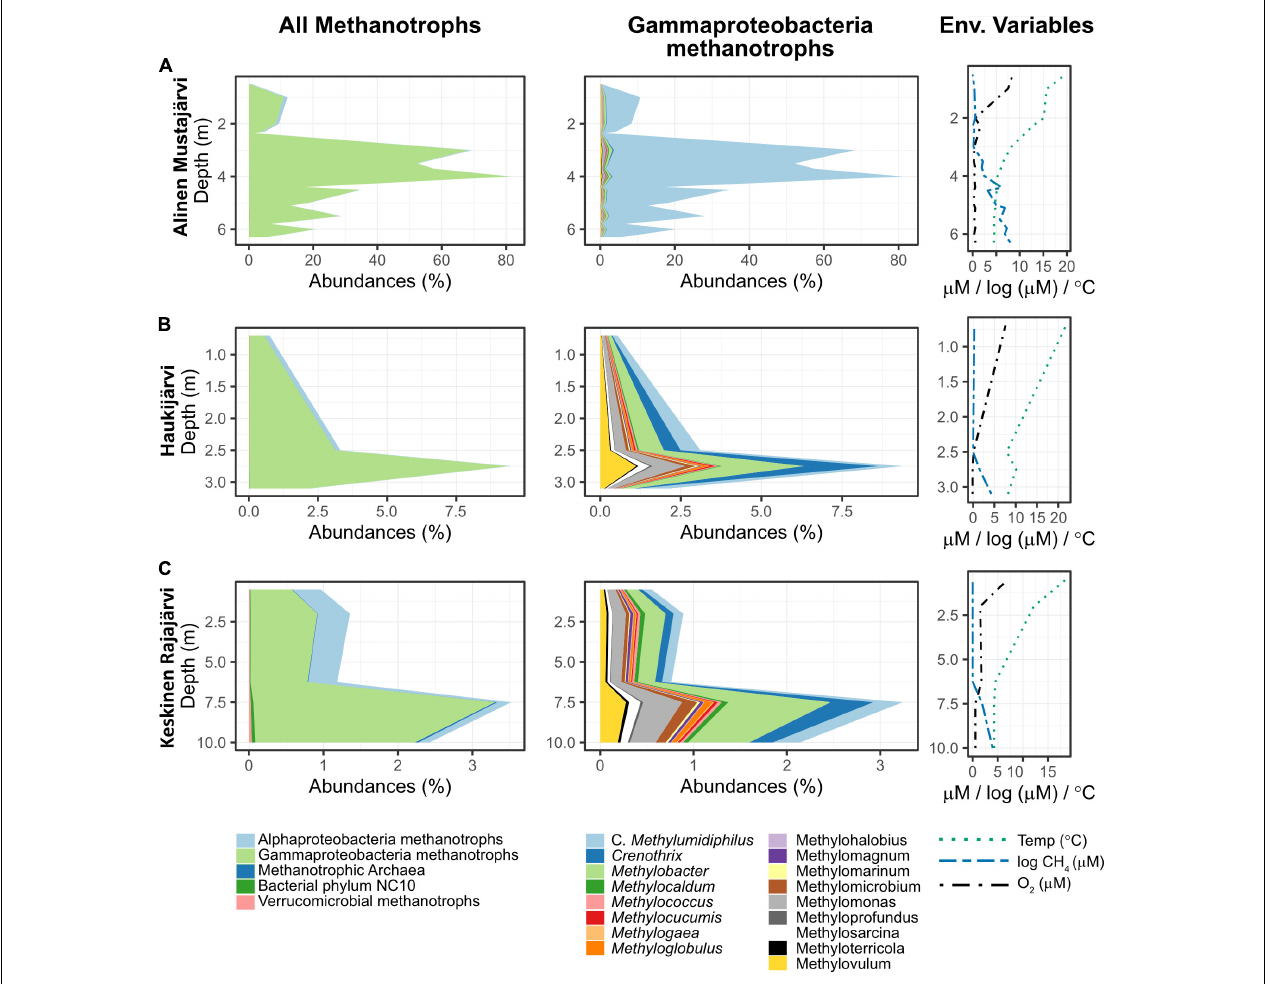
FIGURE 3 | Vertical variation in the relative abundance of methane oxidizers and different genera of gammaproteobacterial methanotrophs, as well as in key environmental variables. Three lakes were selected to represent the general dominance (i.e., higher relative abundances) of gammaproteobacterial methane oxidizers (A–C) . Alinen Mustajärvi is an example where Candidatus Methylumidiphilus dominates an abundant methanotrophic community (A) , whereas in both Haukijärvi and Keskinen Rajajärvi, the most abundant genus in methanotrophic community is Methylobacter (B,C) . Keskinen Rajajärvi also shows a higher dominance of alphaproteobacterial methanotrophs in the epilimnion (C) . Please note the much higher abundance of methanotrophs in Alinen Mustajärvi (A) . The profiles for the rest of the lakes that had data for at least three depths are available in the Supplementary Figure 1 . Note the change in scale of abundance and depth from one lake to the